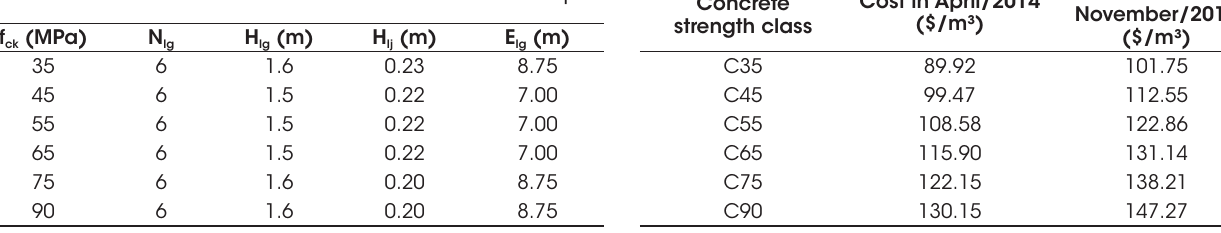
Geometrical characteristics of the decks of Group